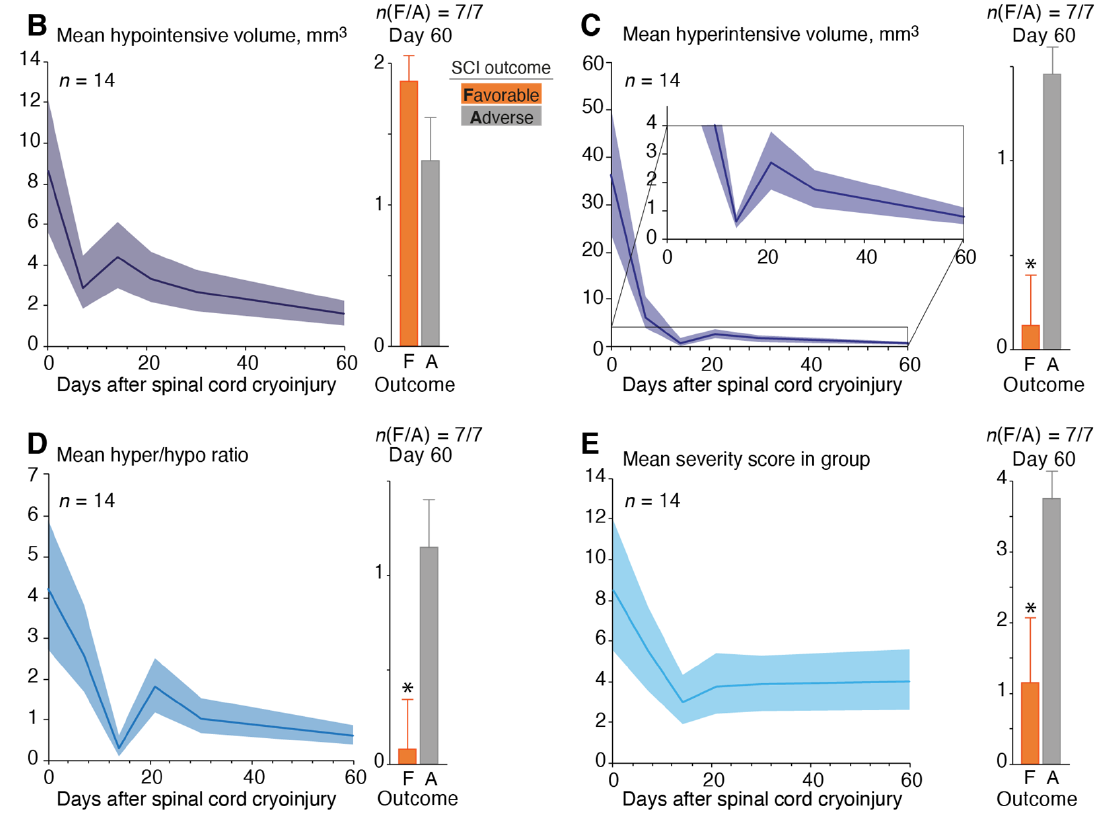
Figure 3. Magnetic resonance imaging of the spinal cord cryoinjury. ( A ) Representative MRI at 0, 7,14, 21, 30 and 60 days. Mean hypointensive ( B ) and hyperintensive ( C ) volume. Mean hyper/hypo ratio ( D ) and mean severity score ( E ). Colored area represents standard deviation. Right bars on each plot demonstrate values at day 60 in groups with favorable (F) and adverse (A) outcomes. Standard deviation and statistically significant difference (*) are shown.